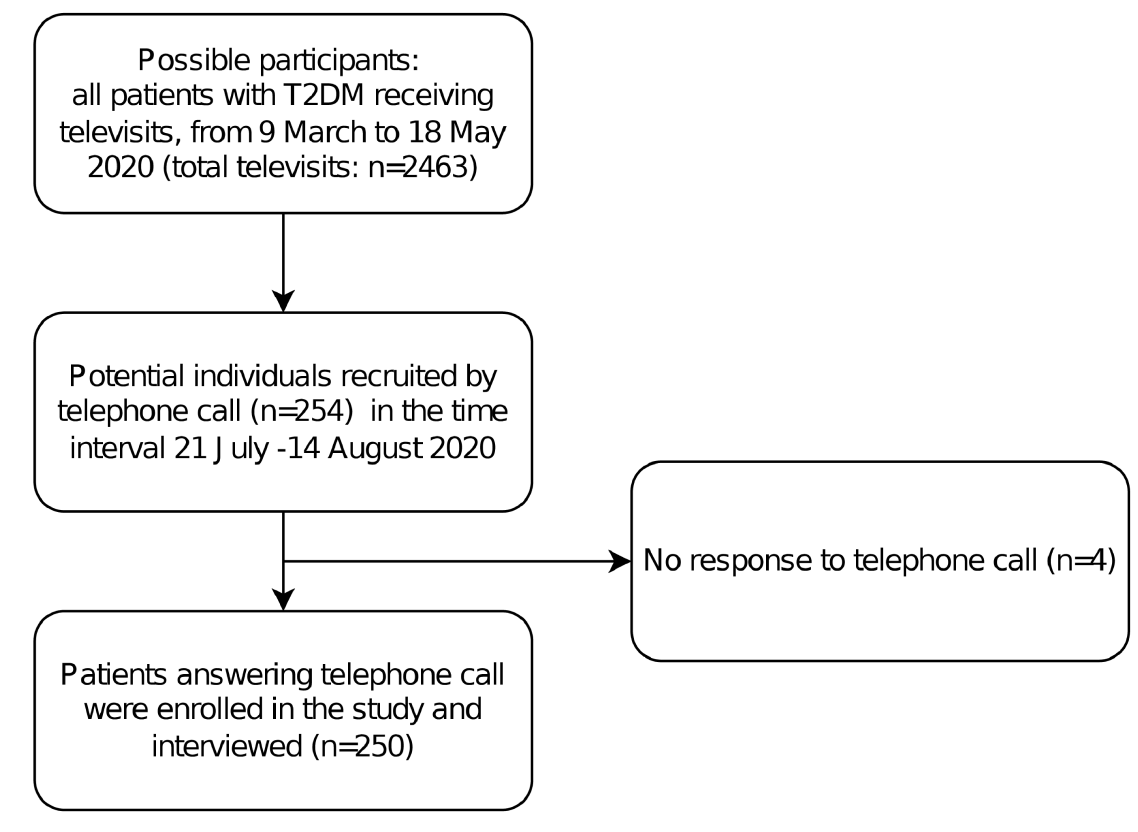
Fig 1. STROBE diagram for various phases of the